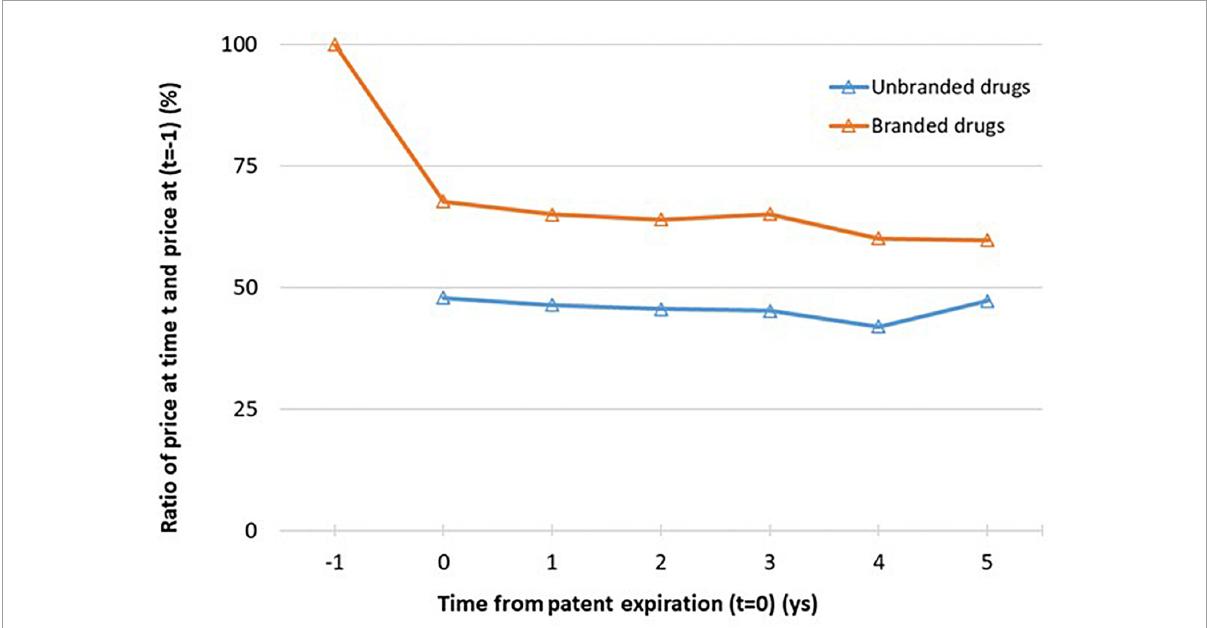
FIGURE3 Relative price per dose of unbranded and branded drugs at lag time t ( t = 0,...,6) to branded price a year before the patent expiration, t = − 1 (i.e. 12 months before the index date). See Figure 1b for the number of available ATCs for each time point. *Sample size at each time point: n = 42 ( t = 0), n = 34 ( t = 1), n = 24 ( t = 2), n = 18 ( t = 3), n = 11 ( t = 4), n = 5 ( t =